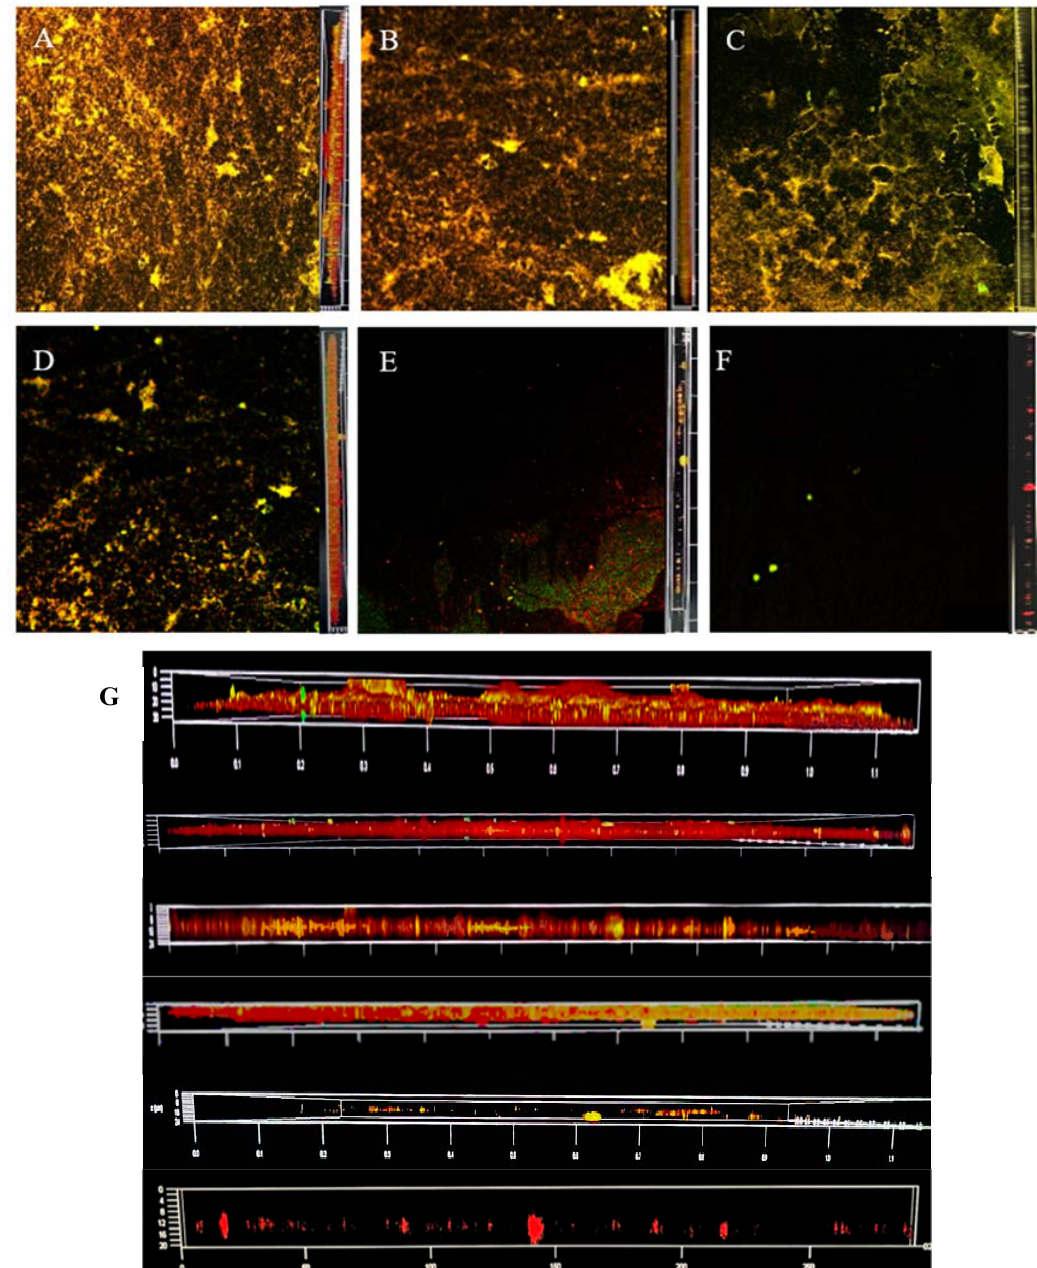
Figure 8. The changes of eDNA and eRNA in LM biofilm after SAEW treatment observed by CLSM; each sample randomly selects three visual fields. Images include front and side views of the biofilm under CLSM. Scale bar—100 µ m. ( A – F ) represent treatment 0, 2, 4, 6, 8, 10 min, respectively. ( G ) is an enlarged version of all the images on the right and is also a right-hand view of the biofilm, from top to bottom, for SAEW treatments 0, 2, 4, 6, 8 and 10 min respectively. SAEW was the abbreviation of slightly acidic electrolytic